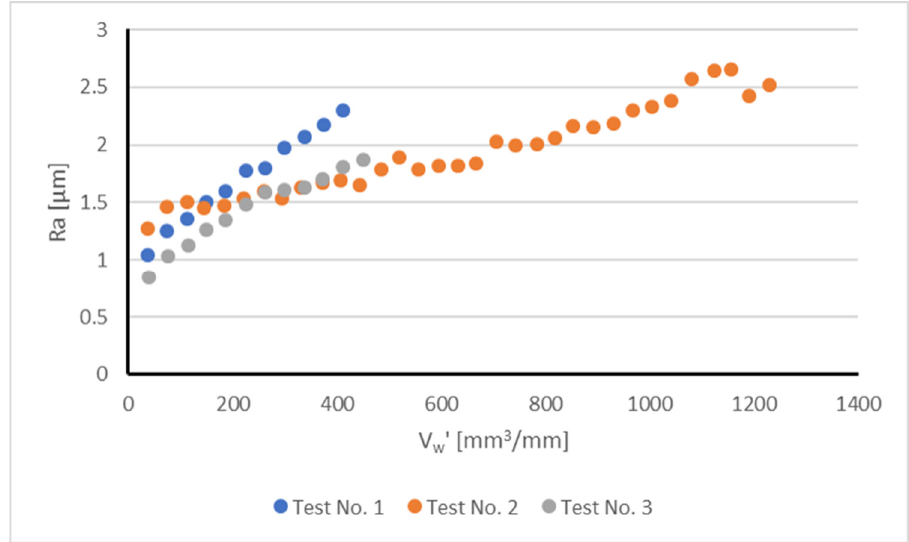
Figure 4. Average surface roughness R a ( µ m) as a function of the specific volume of part material removed V’ w (mm 3 /mm) during the tests.